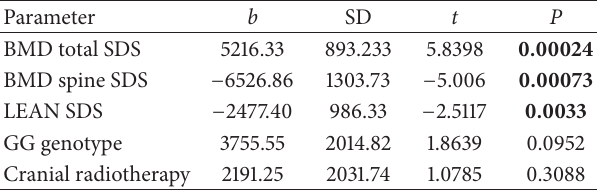
Table 10: Stepwise forward regression model for leptin